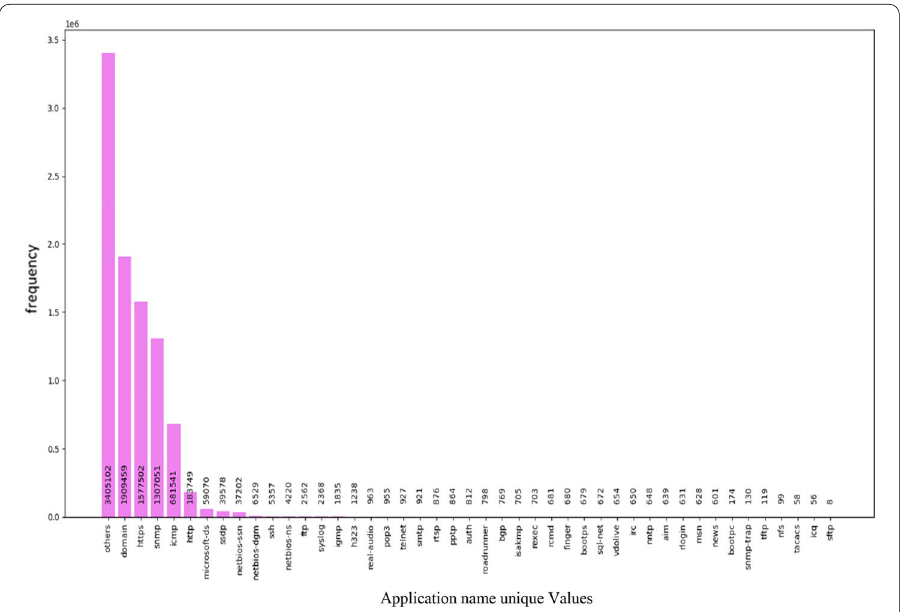
Fig. 1 Bar plot to illustrate frequency of unique values in application name